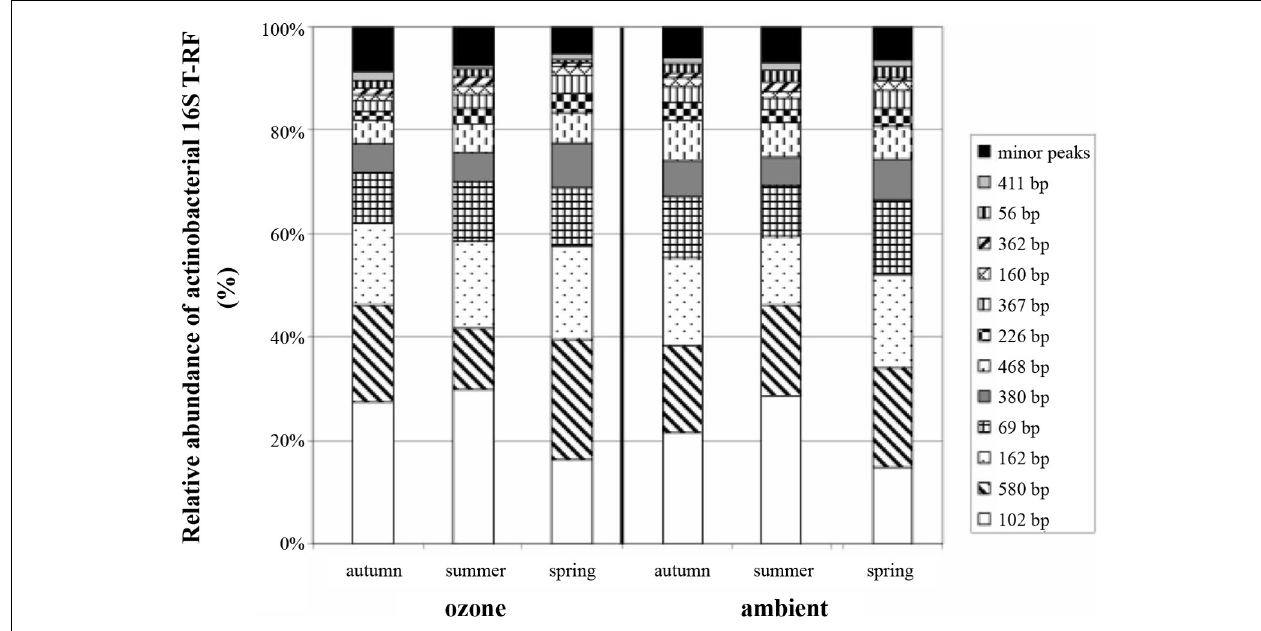
FIGURE 2 | Average relative abundance of actinobacterial 16S rRNA gene T-RFs from replicate soil samples. Peak size is given in base pairs, and relative abundance of T-RFs is given as percentage of total peak height.